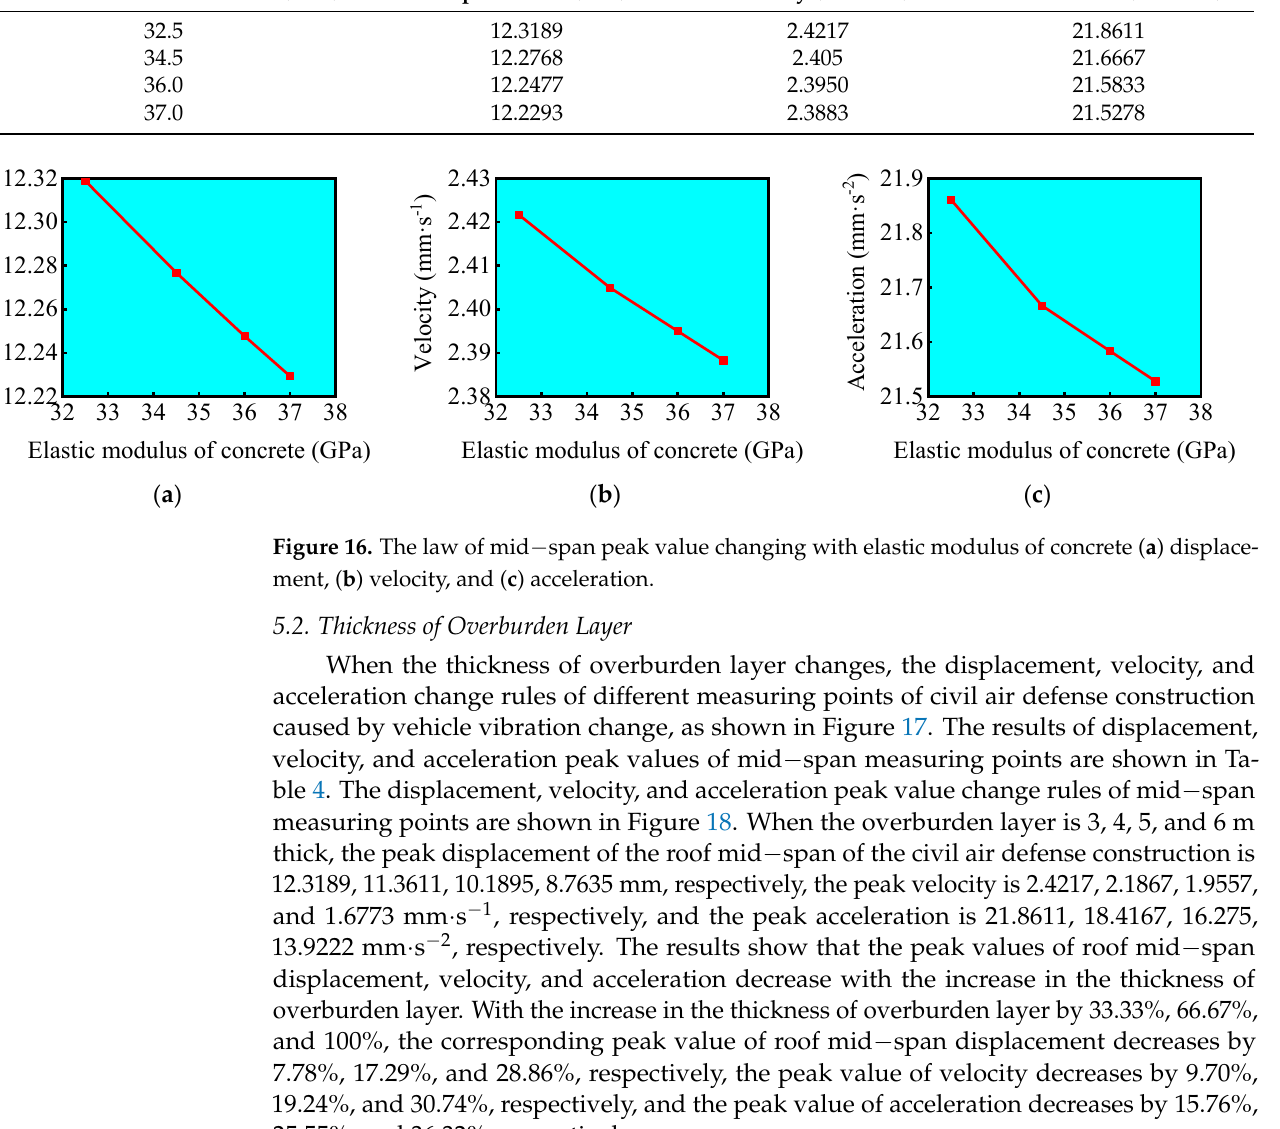
Figure 16. The law of mid − span peak value changing with elastic modulus of concrete ( a ) displace- ment, ( b ) velocity, and ( c ) acceleration.